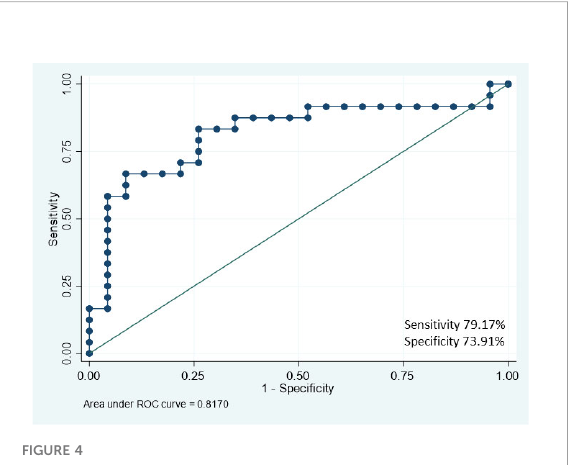
FIGURE 4 ROC curve for SRL response prediction performed according to the selected